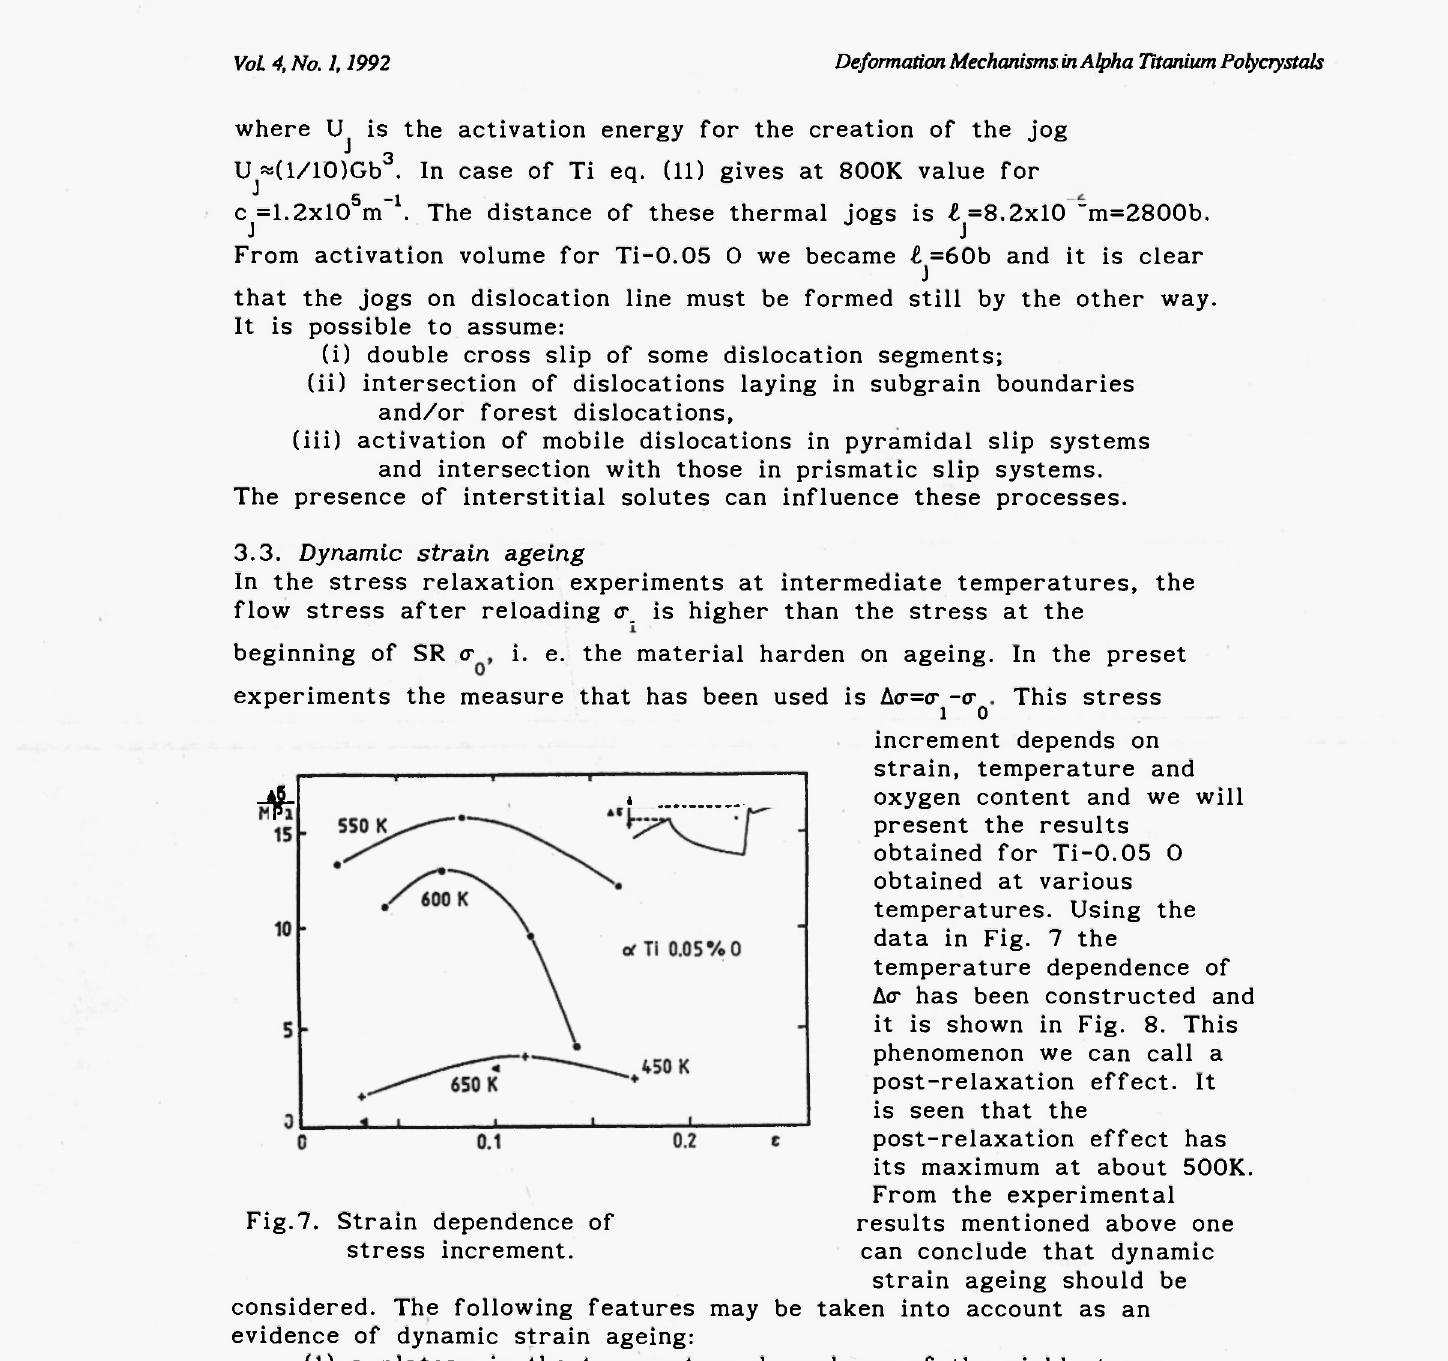
Fig.7. Strain dependence